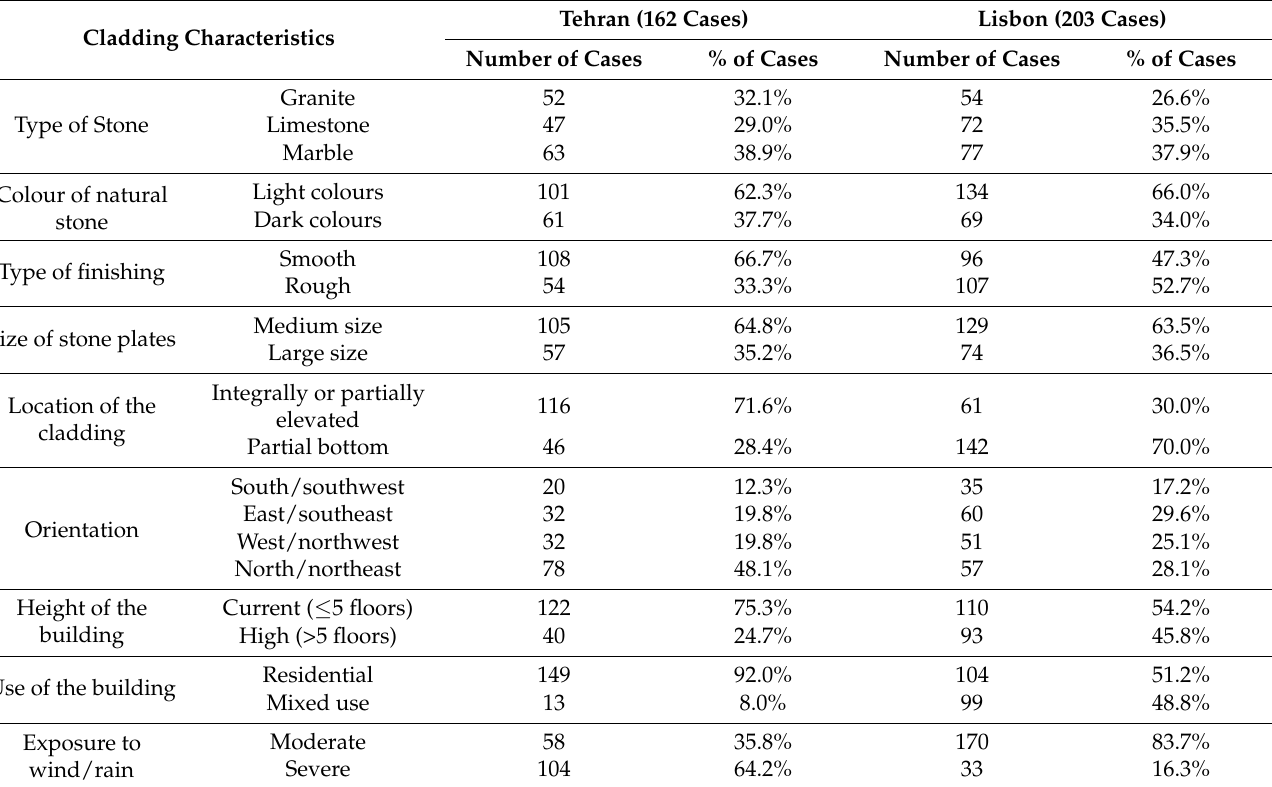
Table 1. Description of the samples collected in Tehran and in